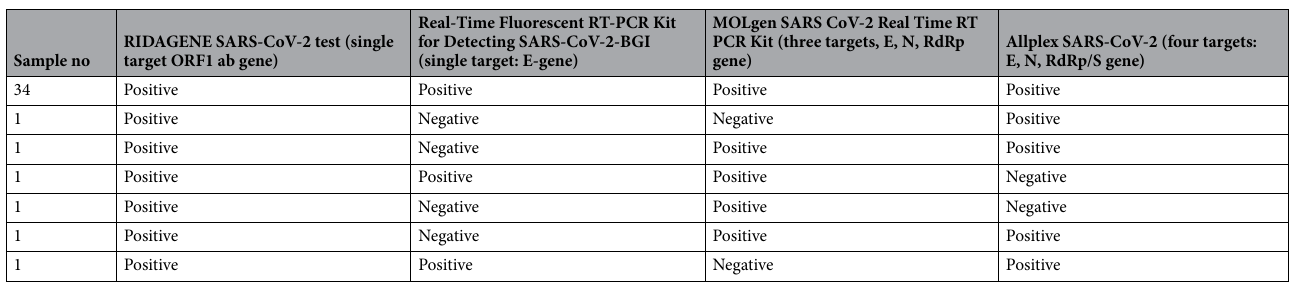
Table 2. Limit of Detection (LoD) of our assay evaluated using Research Reagent for SARS-CoV-2 RNA (NIBSC code 19/304) from the National Institute for Biological Standard and Control.